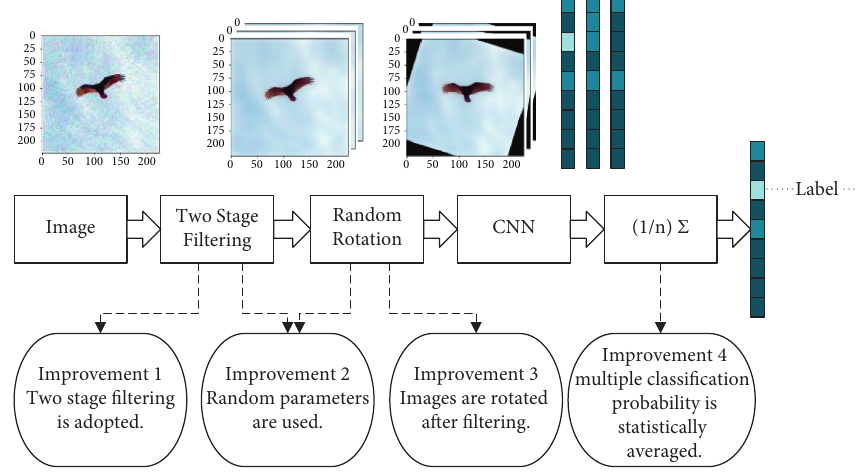
Figure 1: The improved defense procedure by the proposed method in four